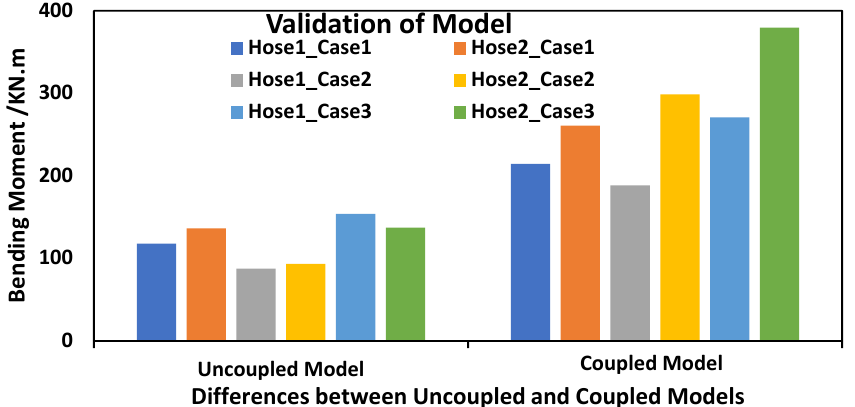
Table 12. Validation study using the bending moment of the submarine hose. Parameters